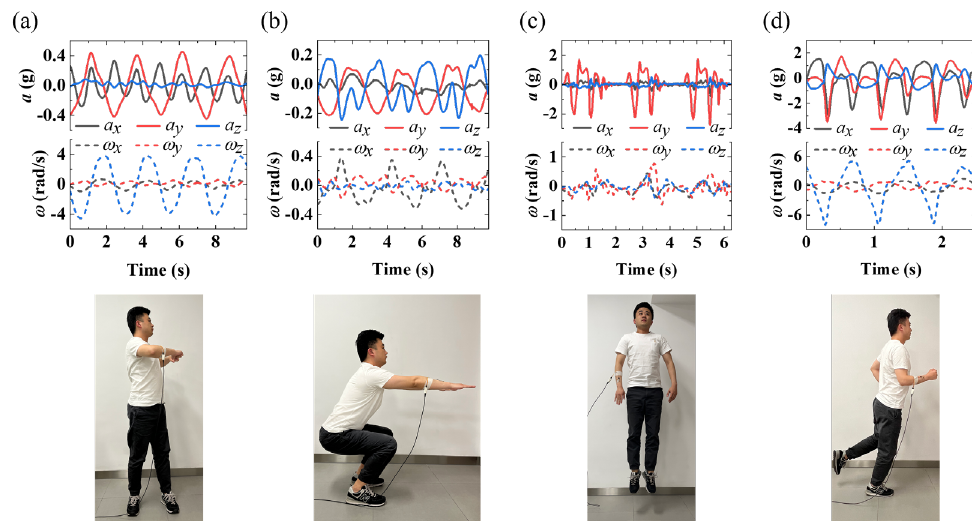
Figure 4. Real-time acceleration and axial angular of/around X − axis, Y − axis, and Z − axis direction during ( a ) arm twisting, ( b ) squatting, ( c ) jumping, ( d ) running.